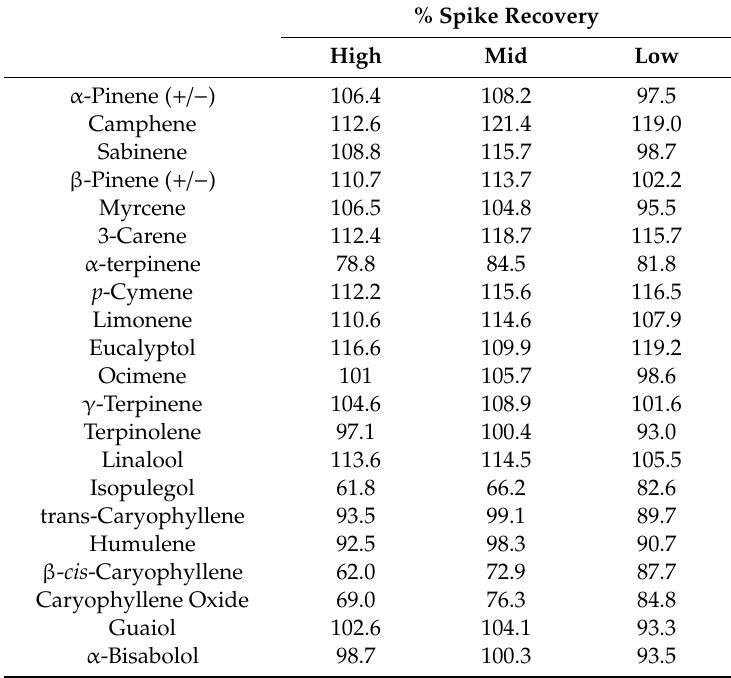
Table 3. Recovery of analytes in spiked sample at three concentration